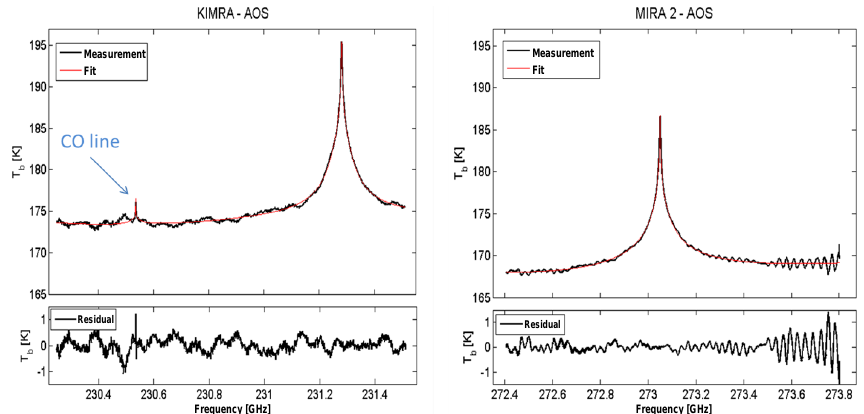
Figure 1. Example spectra and fits for a KIMRA_O 3 CO measurement and a MIRA 2 measurement. Note: the visible oscillatory pattern in the baseline of the MIRA 2 spectra has recently been eliminated after servicing of the AOS spectrometer.